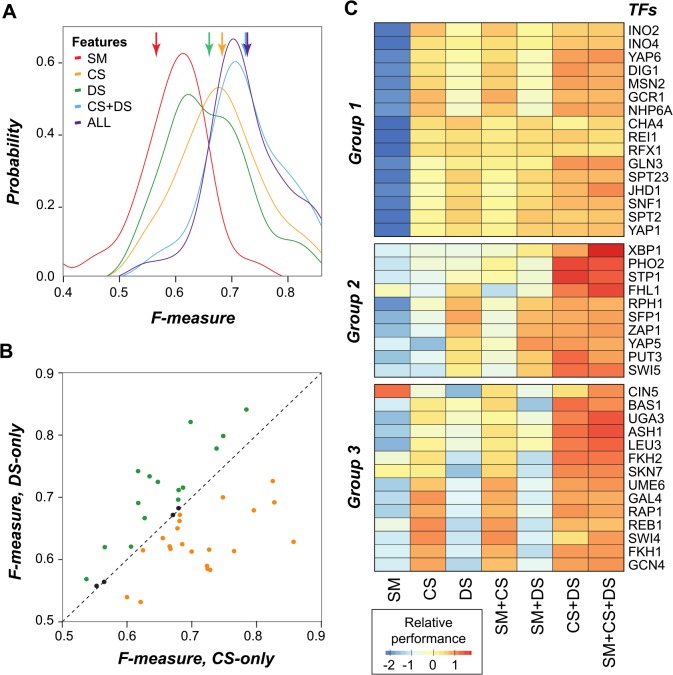
Contribution of SM, CS, and DS features to overall and individual TF binding region prediction.(A) The F-measure distributions of random forest classifications with different individual features or combinations of features. The y-axis indicates the probability with a specific F-measure. The arrowheads indicate the average F-measures. (B) The relationship between F-measures of binding predictions based on CS features only and DS features only. The dotted line shows the 1-to-1 relationship. Points in green (yellow) represent the TFs in which performance is better in the DS-only (CS-only) model. (C) Heat map showing the relative performance (i.e. standardized the F-measures to mean zero and variance one) in predicting binding region of each TF using individual features or combinations of features. The TFs are grouped into three classes: TFs with binding regions that can be predicted by either CS or DS (Group 1); TFs with binding regions that cannot be predicted well with only CS (Group 2) or only DS (Group 3) features.